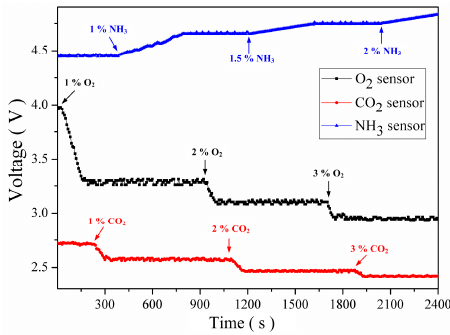
Figure 10. Simultaneous measurement of the voltage responses of the O 2 , CO 2 , and NH 3 sensors.